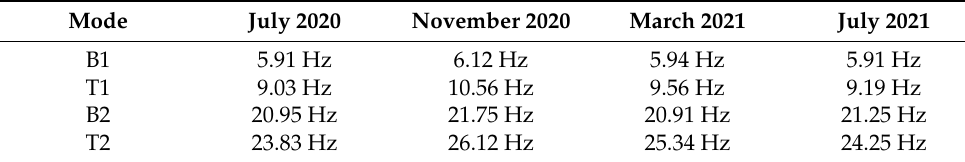
Table 4. Span S2: identified natural frequencies among the different tests. Mode